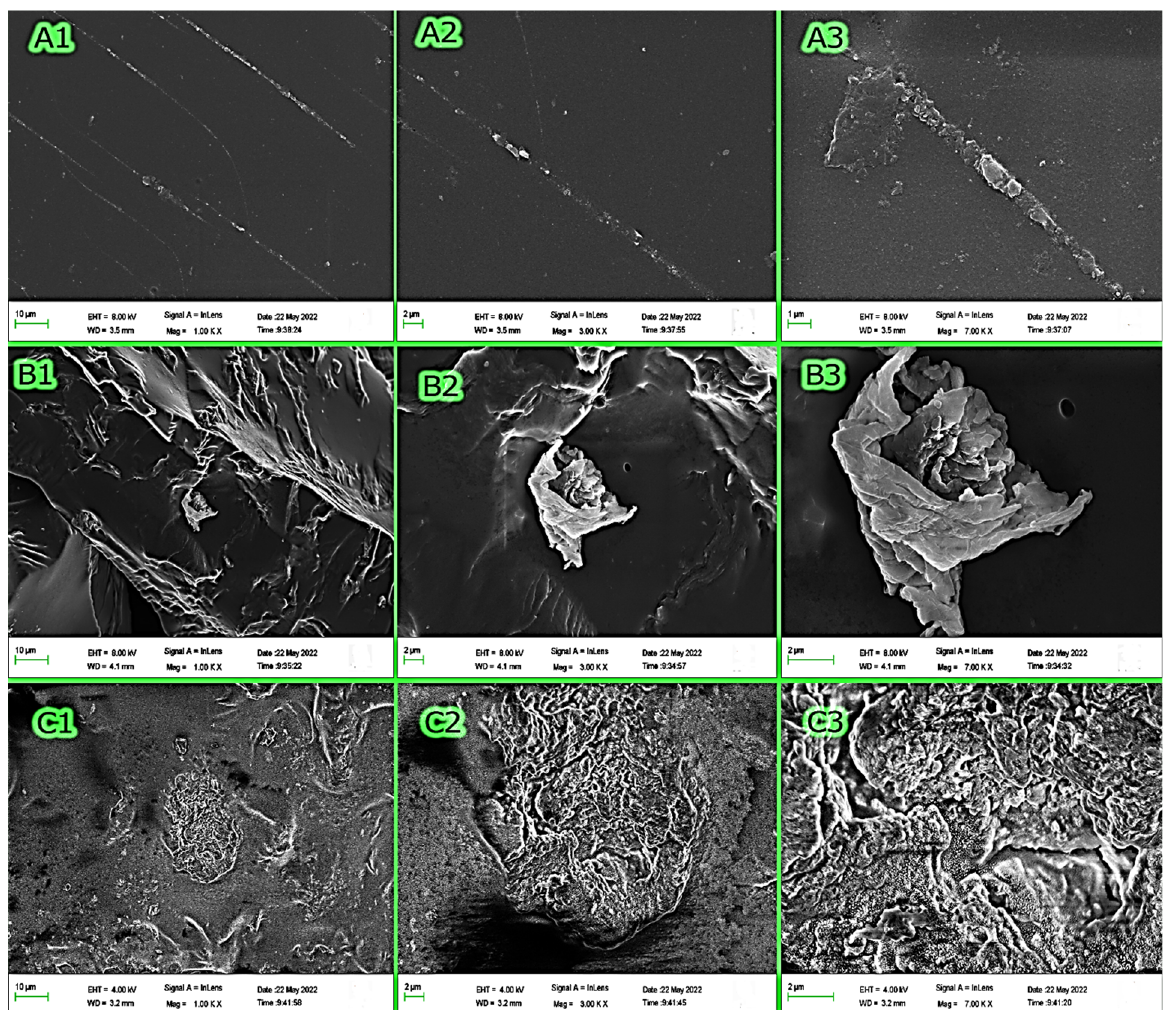
Figure 5. SEM images of polymer F ( A ), Polymer E ( B ), and MB adsorbed on polymer E ( C ).